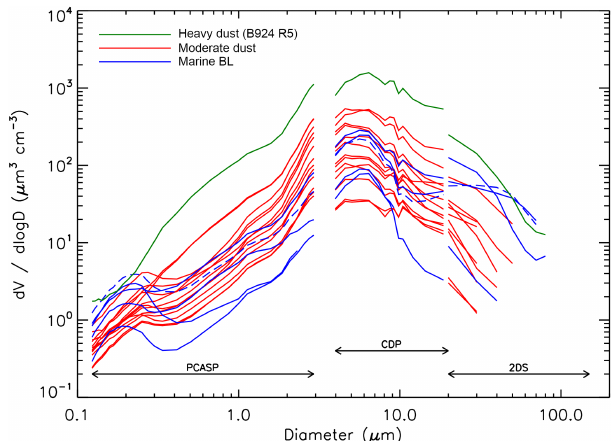
Figure 2. Particles size distributions obtained during in situ straight- level runs using the PCASP (0.1–3µm), CDP (4–20µm) and 2DS ( > 20µm). Blue: MBL; red: SAL, moderate dust loading; dark green: SAL, heavy dust loading (flight B924 run 5); dashed blue: MBL under heavy dust layer (flight B924 run